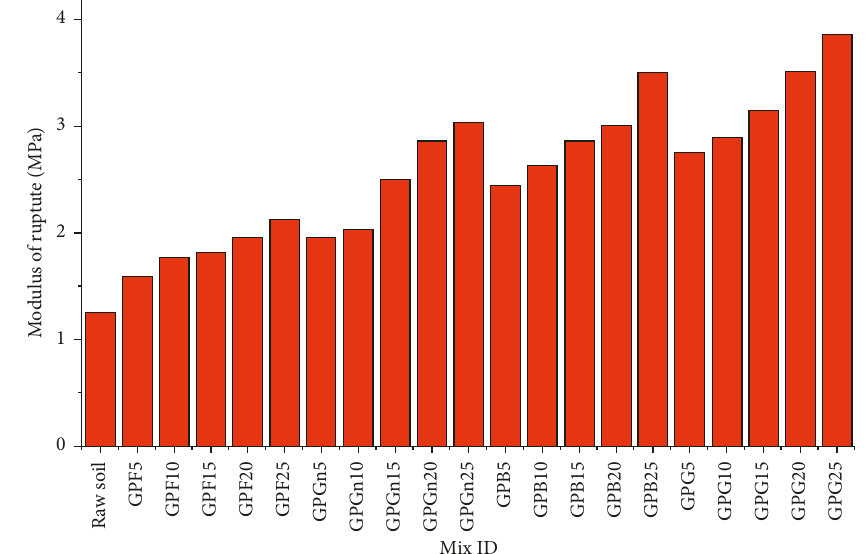
Figure 4: Flexural strength for stabilized geopolymer mud